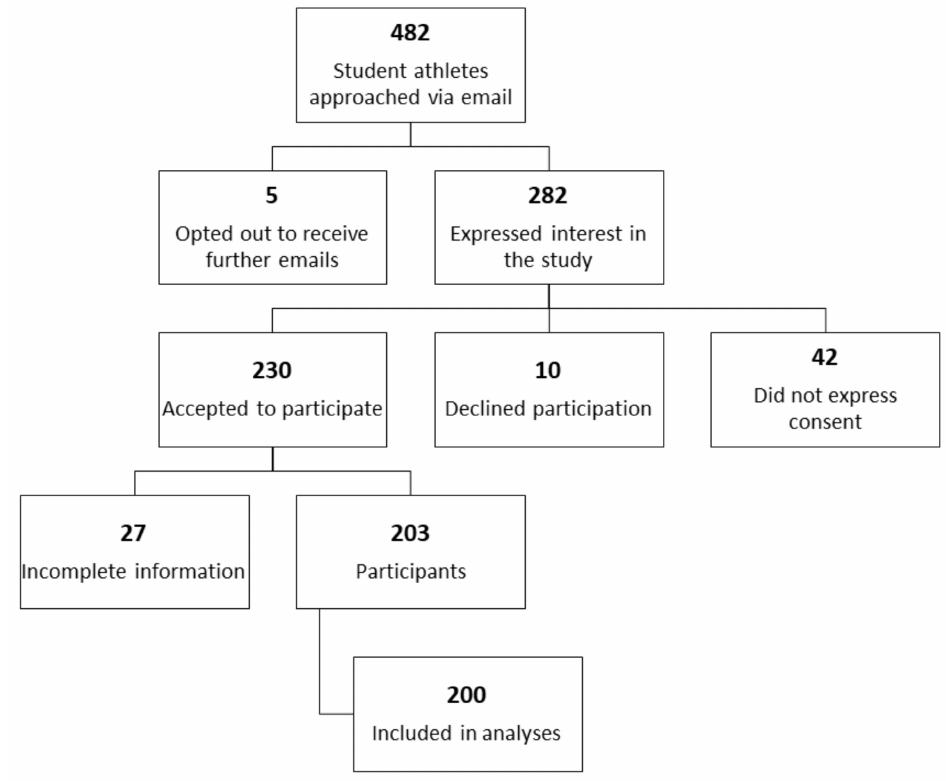
Figure 1. Participant recruitment